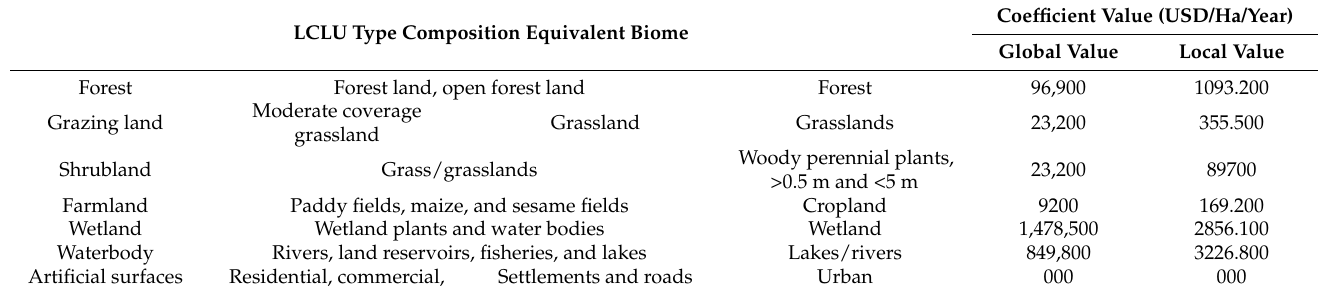
Table 3. Land cover and land-use types with their ecosystem service value coefficient equivalents (USD/ha/).